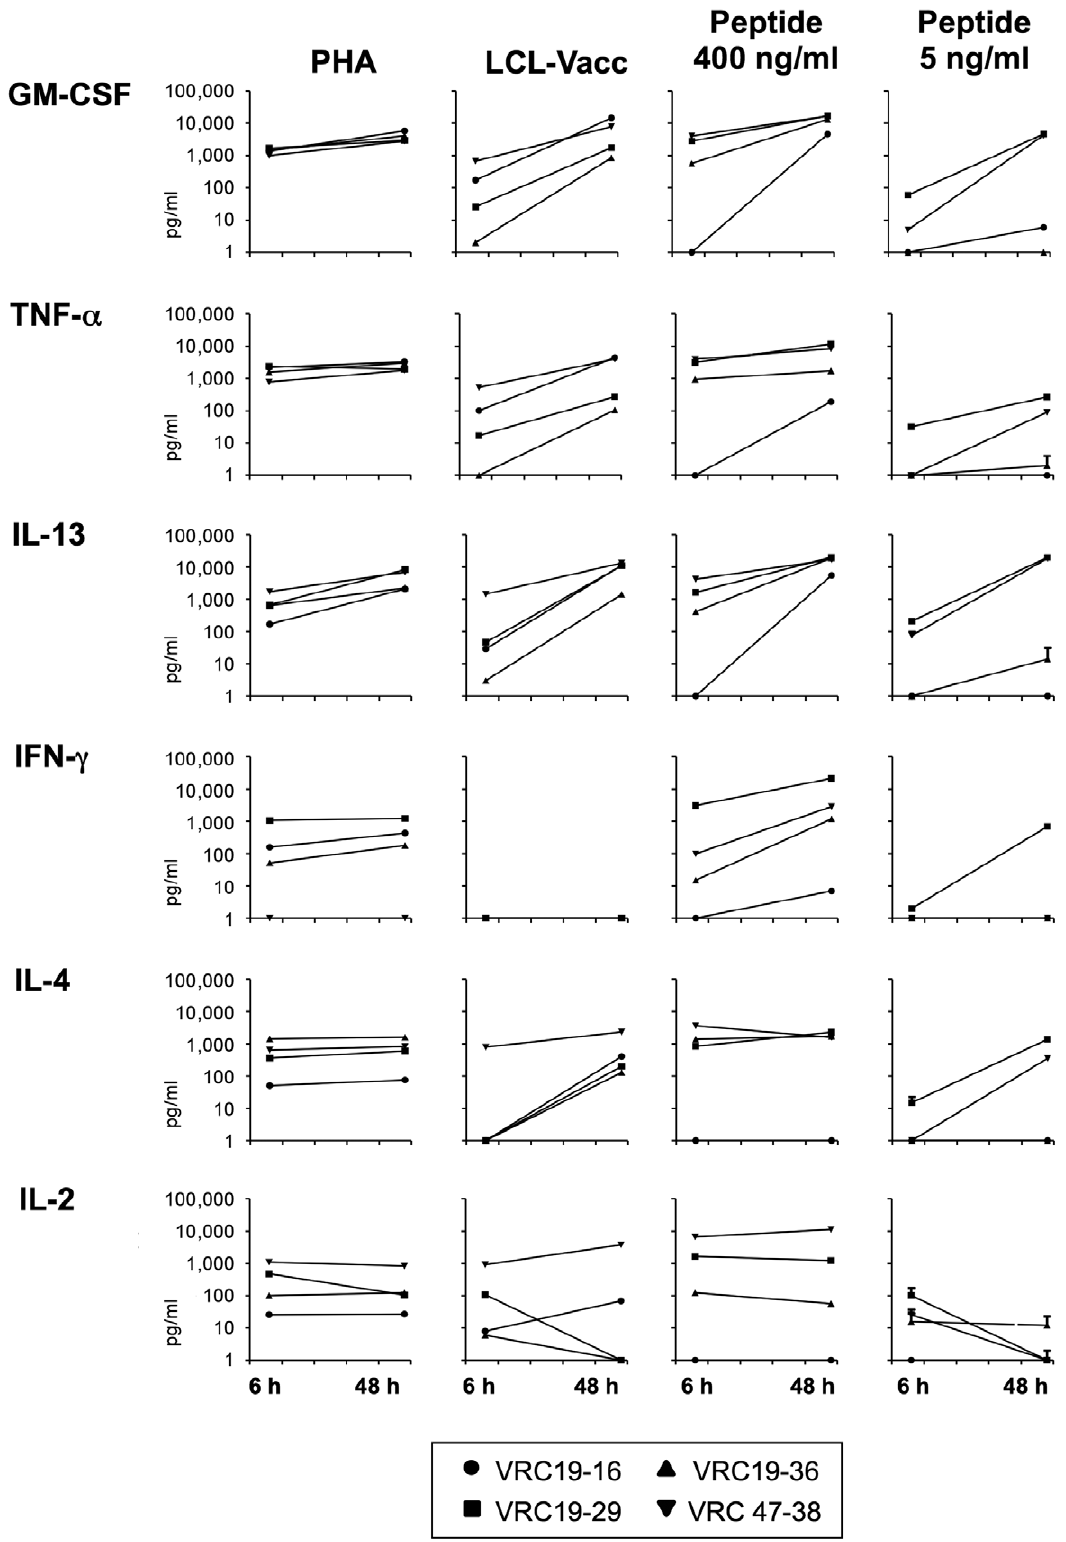
Figure 5. Cytokine production by CD4 + T cell clones. Vaccinia peptides were tested in a dose response assay with their specific T cell clone (2.5 6 10 4 ) in the presence of autologous LCL (5 6 10 4 ) in duplicate wells. Graphs show the cytokine production in response to 5 and 400 ng/ml of peptide (values for background wells were subtracted) at 6 hours and 48 hours post-stimulation. T cell clones were cultured in the presence of autologous LCL (background), vaccinia infected LCL (LCL-Vacc) or PHA. Cytokine production was evaluated by multiplex assay.